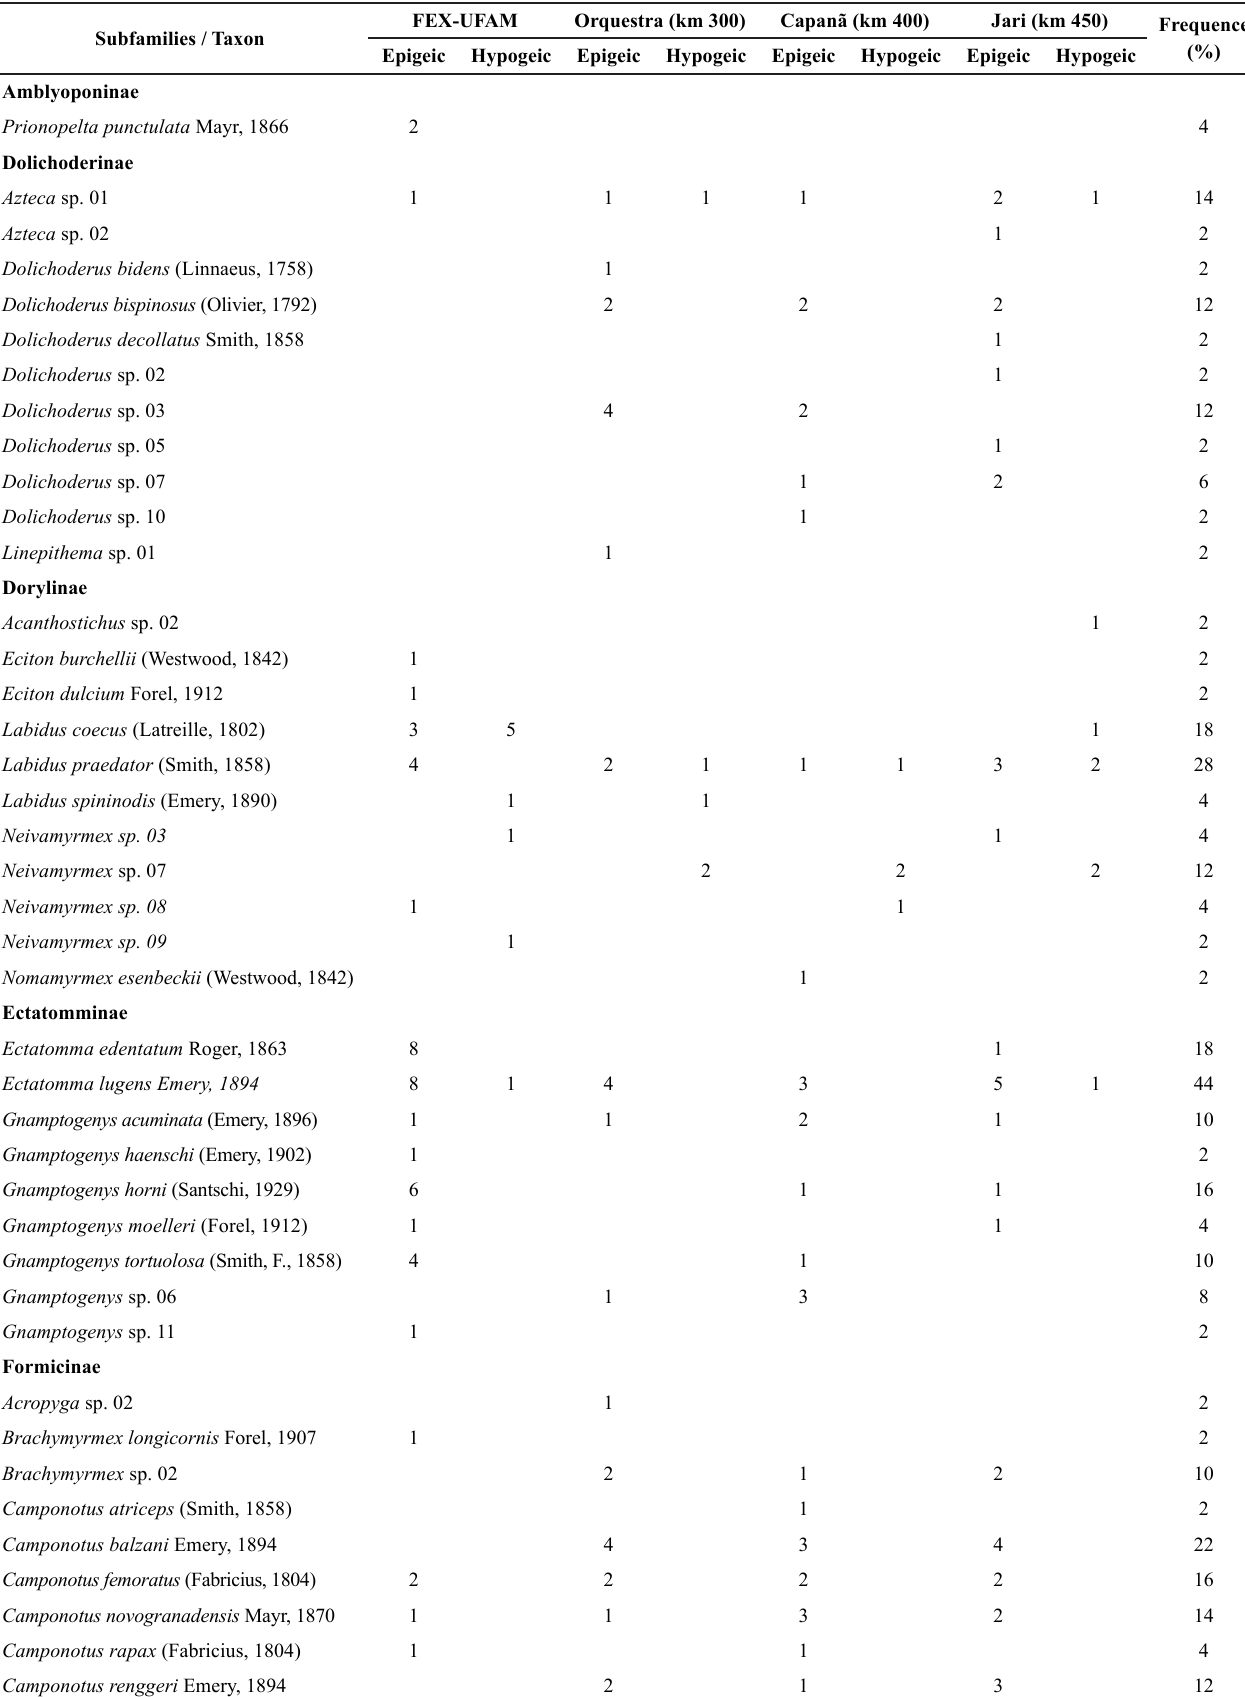
Table 2 . Occurrence and frequency of ant species and morphospecies sampled in the hypogeic (10 plots) and epigeic (7 plots) strata at UFAM and on BR 319 modules Orquestra, Capanã and Jari (5 plots in both strata for each